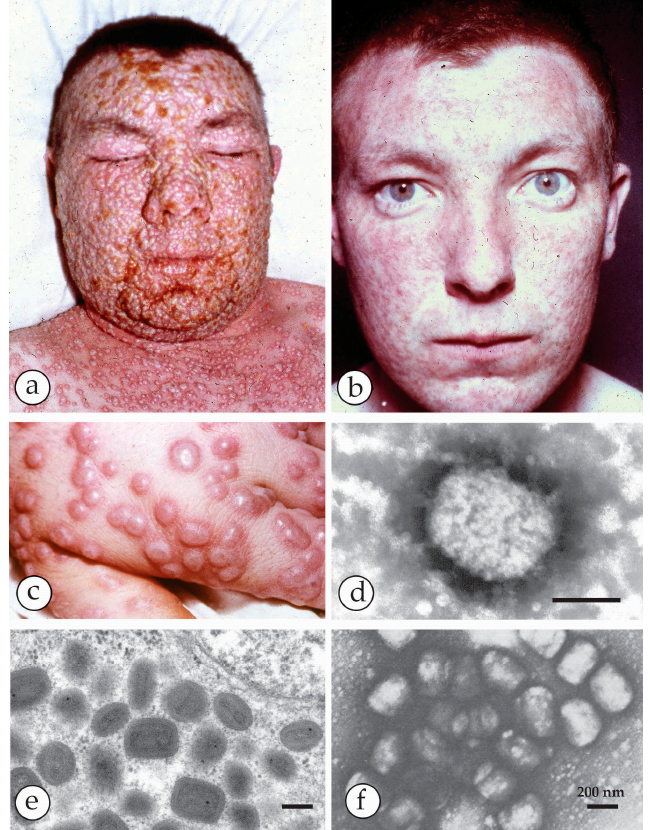
Figure 1. Last cases of endemic smallpox in Europe: ( a , b ) Smallpox patient from the 1962 outbreak in South Wales. ( a ) At the acute stage, with marked facial oedema, and ( b ) after recovery. He was 17 at the time, but looked middle-aged in the first photo. ( c ) The hand of one of the cases showing deep-seated, compact vesicles, often umbilicated and mostly at the same developmental stage. ( d ) Negative staining (NS) DEM of vesicle fluid with PTA (Potassium phosphoTungstic Acid) revealed brick-shaped particles of the proper OPV size. ( e , f ) Thin section (TS) TEM (Transmission Electron Microscopy) and DEM of the last smallpox case in Germany [30]. ( e ) Virus was isolated on the chorio-allantoic membrane (CAM) and showed in ultrathin sections different cuts through fully assembled OPV. For more detail see Figure 14a,b. ( f ) direct DEM of vesicle fluid showed an abundance of typical OPV particles. ( f ) with kind permission of Thieme Verlag, Stuttgart, Germany. Bars ( d – f ) = 200 nm.